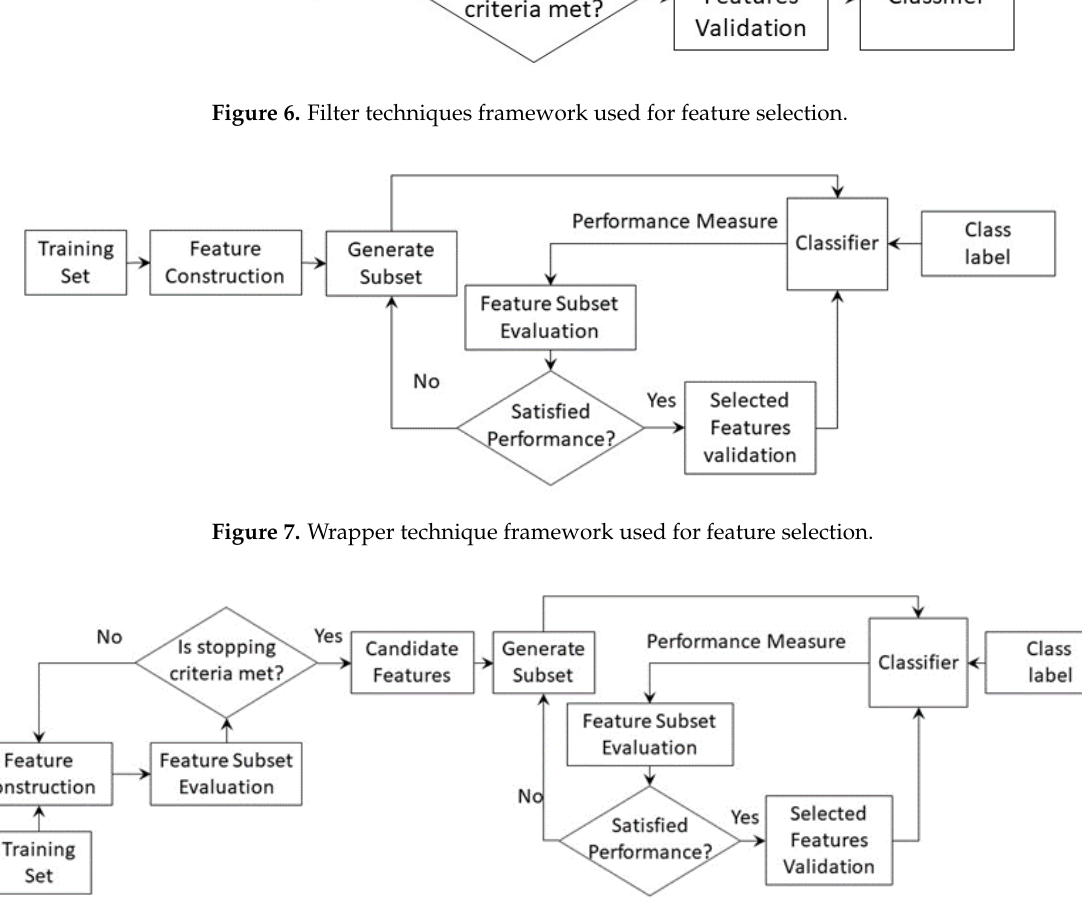
Figure 7. Wrapper technique framework used for feature selection.